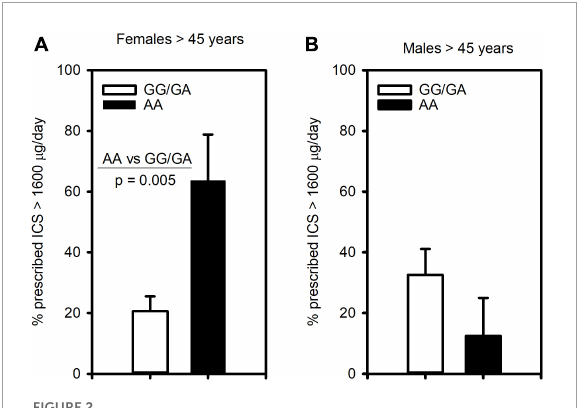
FIGURE1 The CRTh2 rs533116 G > A polymorphism increases risk of severe asthma in older females. Asthmatics with mild/moderate ( n = 109) and severe asthma ( n = 61) were genotyped and odds ratio (OR) and 95% CI were determined. Females 45 years and older carrying the AA genotype were at increased risk of having severe asthma compared to those of GG/GA genotype. Analysis using binary logistic regression were adjusted for age, sex and BMI.